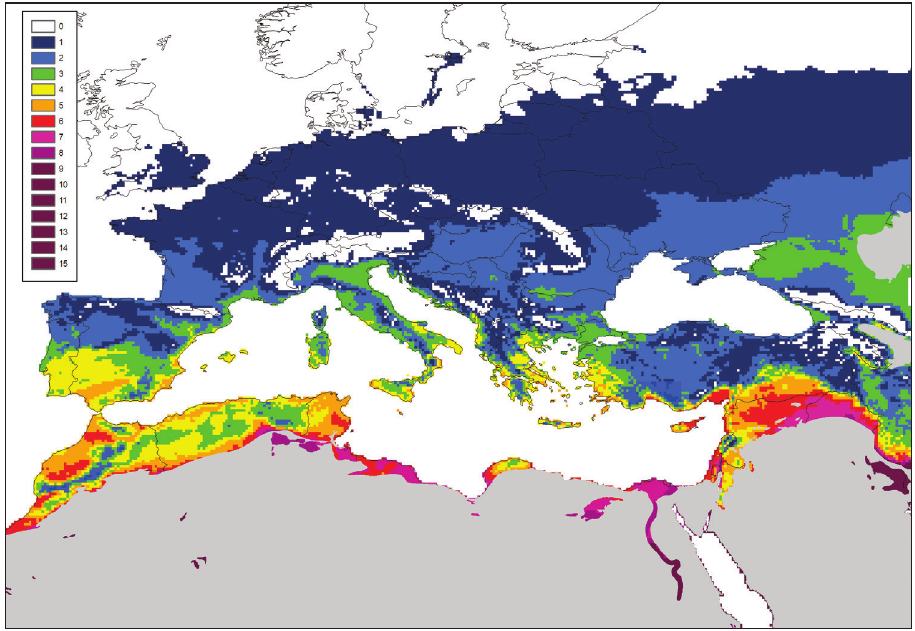
Figure 3. The number of generations for T. leucotreta possible in the EPPO region. This map is based on a minimum development threshold of 12°C and the number of degree days required for each generation of